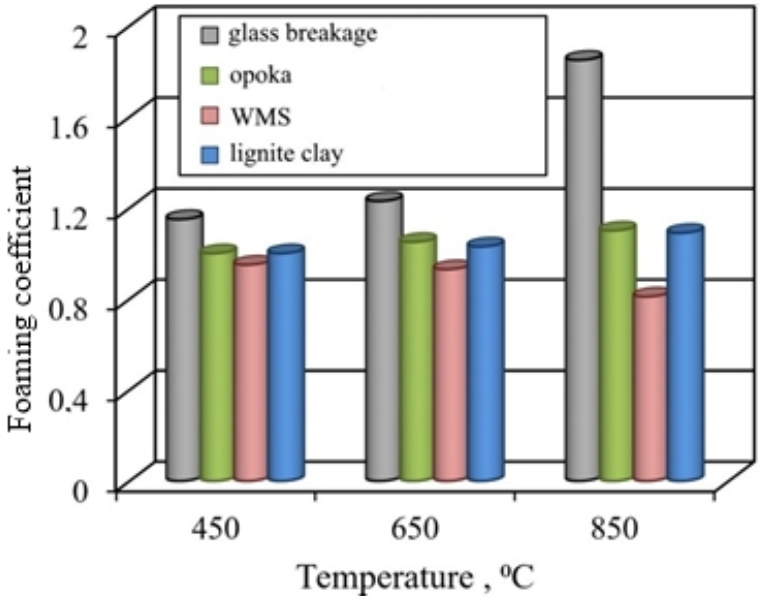
Figure 7. Influence of temperature on the foaming of granules from liquid glass mixtures with various fillers.